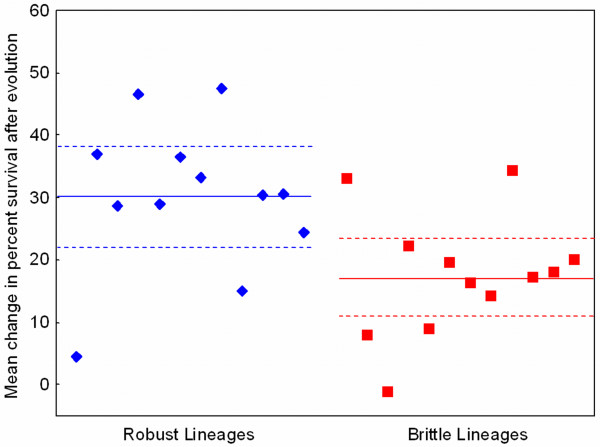
Mean change in percent survival after heat shock (45°C) is greater for virus lineages founded by 12 robust strains (diamonds), relative to that for lineages initiated by 12 brittle strains (squares). All populations were subjected to 10 days (50 generations) of selection in a high temperature environment. Solid line is the grand mean for the group, and dashed lines are 95% confidence intervals.